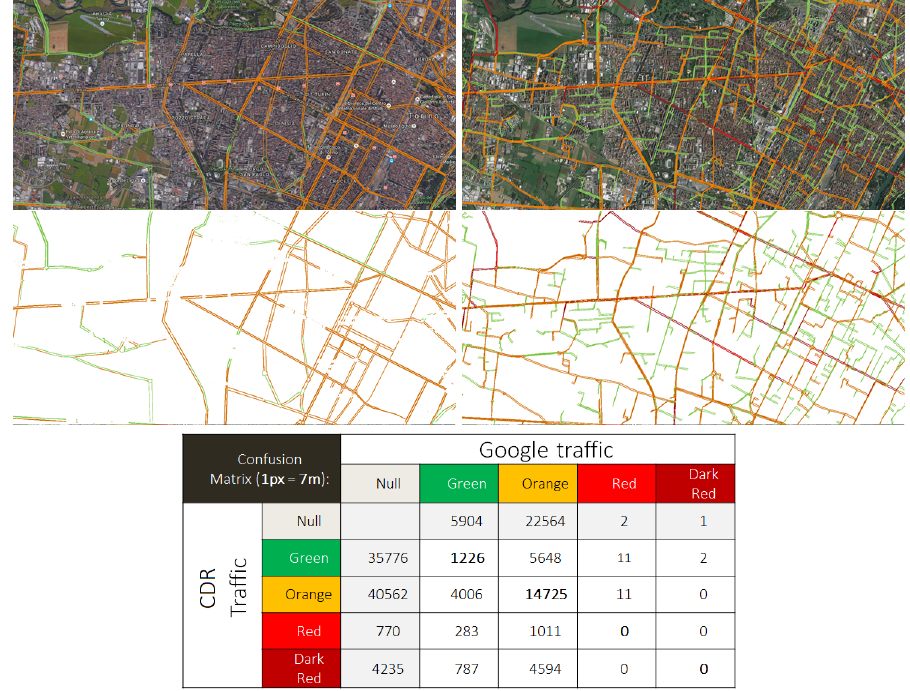
Figure 12. A comparison between Google and CDR-extracted traffic models for Torino. ( left ), Google traffic model—typical Tuesday—9 am; ( right ), CDR traffic model—typical working day—9 am; ( Below ), the related confusion matrix is